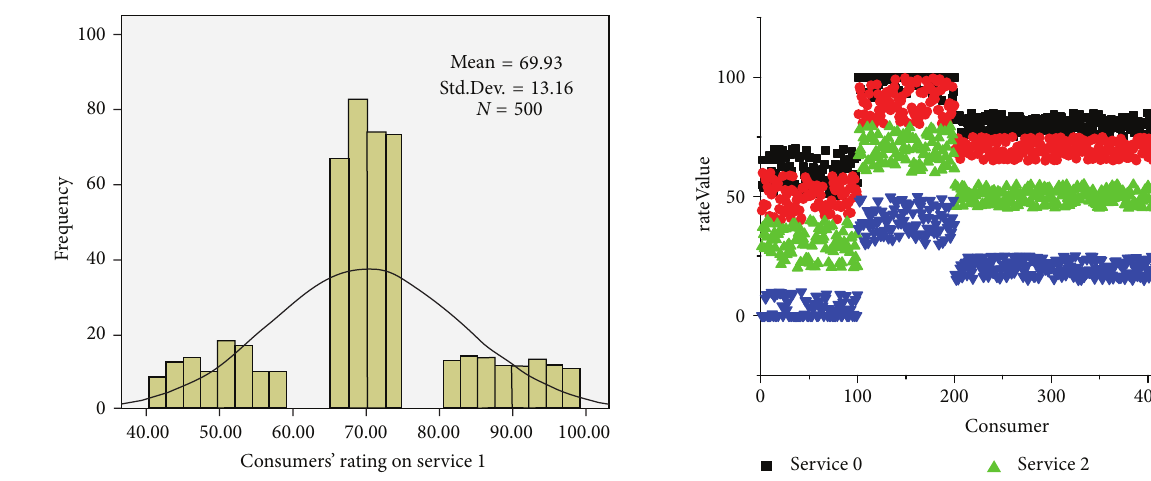
Figure 5: Distribution of rateValue for service 1 in the experiments ( 𝑁 = 500 users).